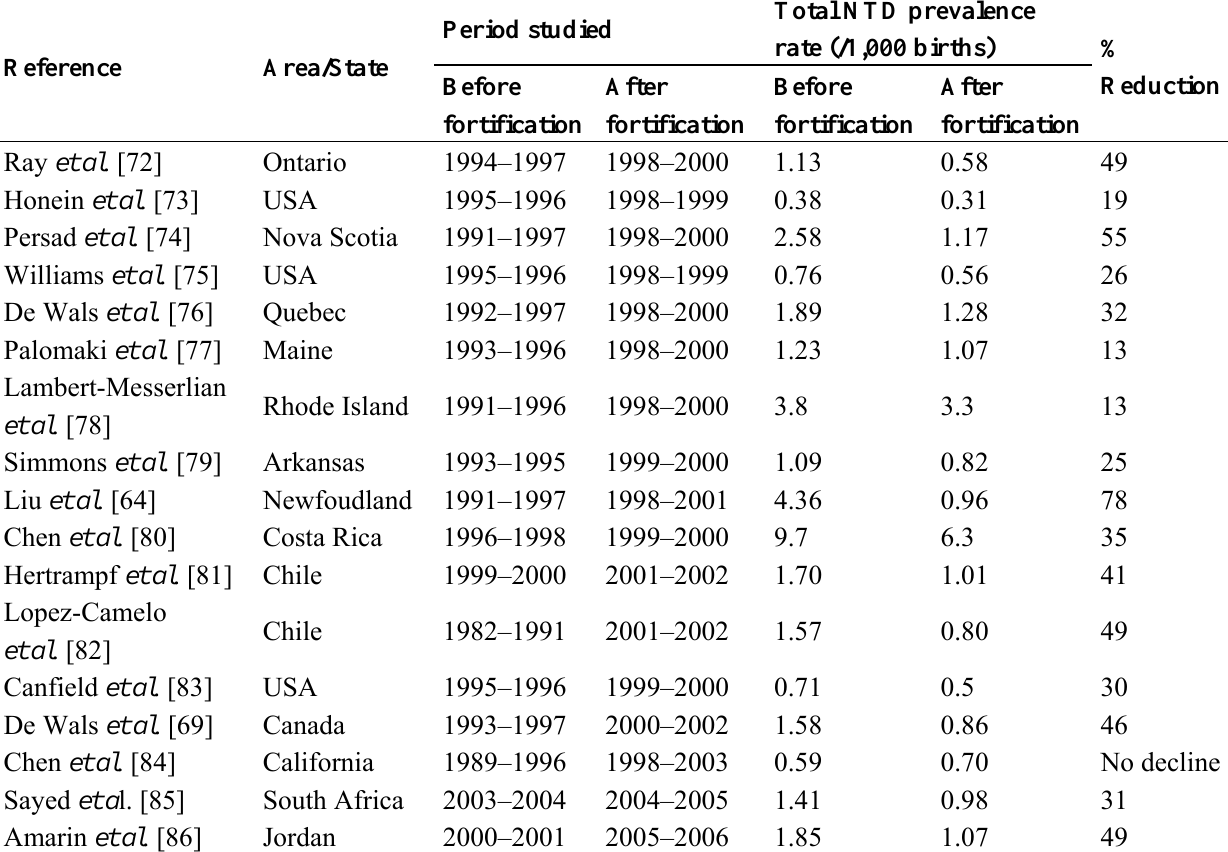
Table 1. Reduction in NTD rates with folic acid